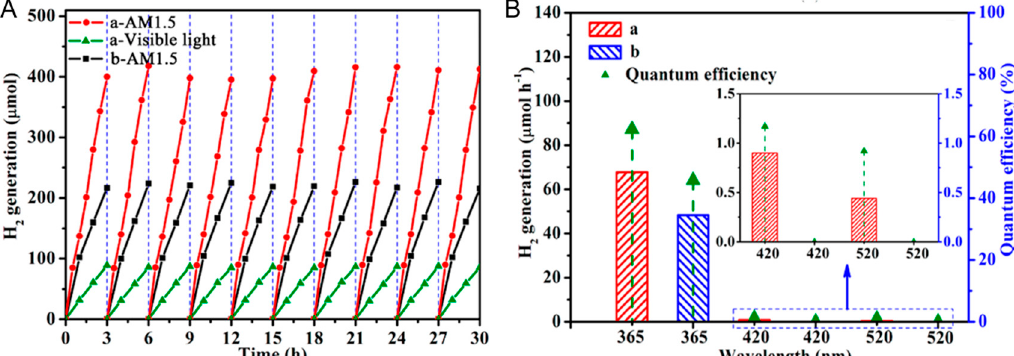
Figure 16. Photocatalytic hydrogen evolution of the ordered mesoporous black TiO 2 (a) and pristine ordered mesoporous TiO 2 materials (b). ( A ) Cycling tests of photocatalytic hydrogen generation under AM 1.5 and visible light irradiation. ( B ) The photocatalytic hydrogen evolution rates under single-wavelength light and the corresponding QE. The inset enlarges the QE of single-wavelength light at 420 and 520 nm. Reprinted with permission for ref. [79]. Copyright 2014, American Chemical Society.